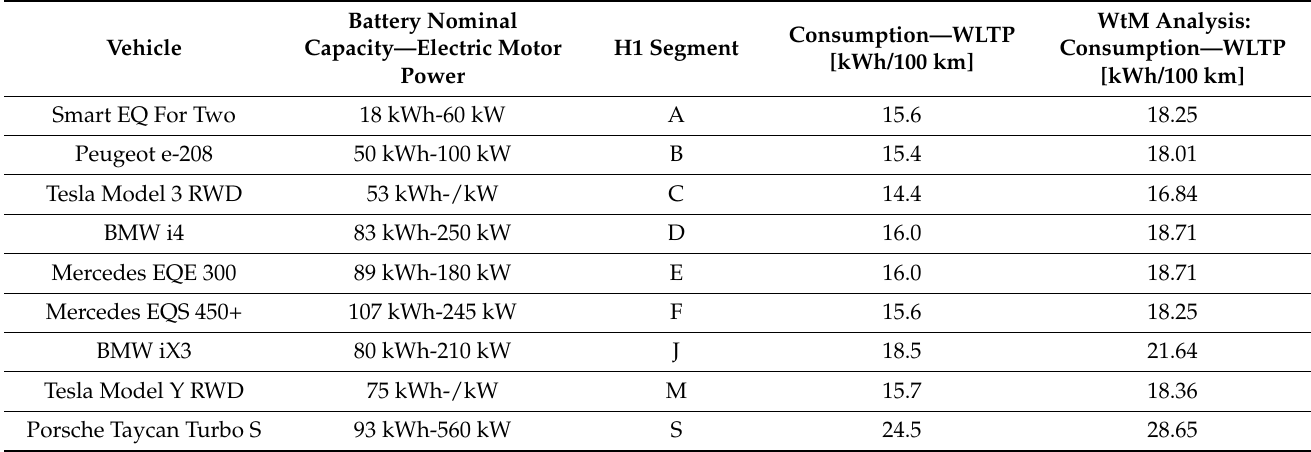
Table 10. Passenger vehicle fleet in Europe: division into powertrain and H1 segments—Powertrain: BEV [15,17,18].